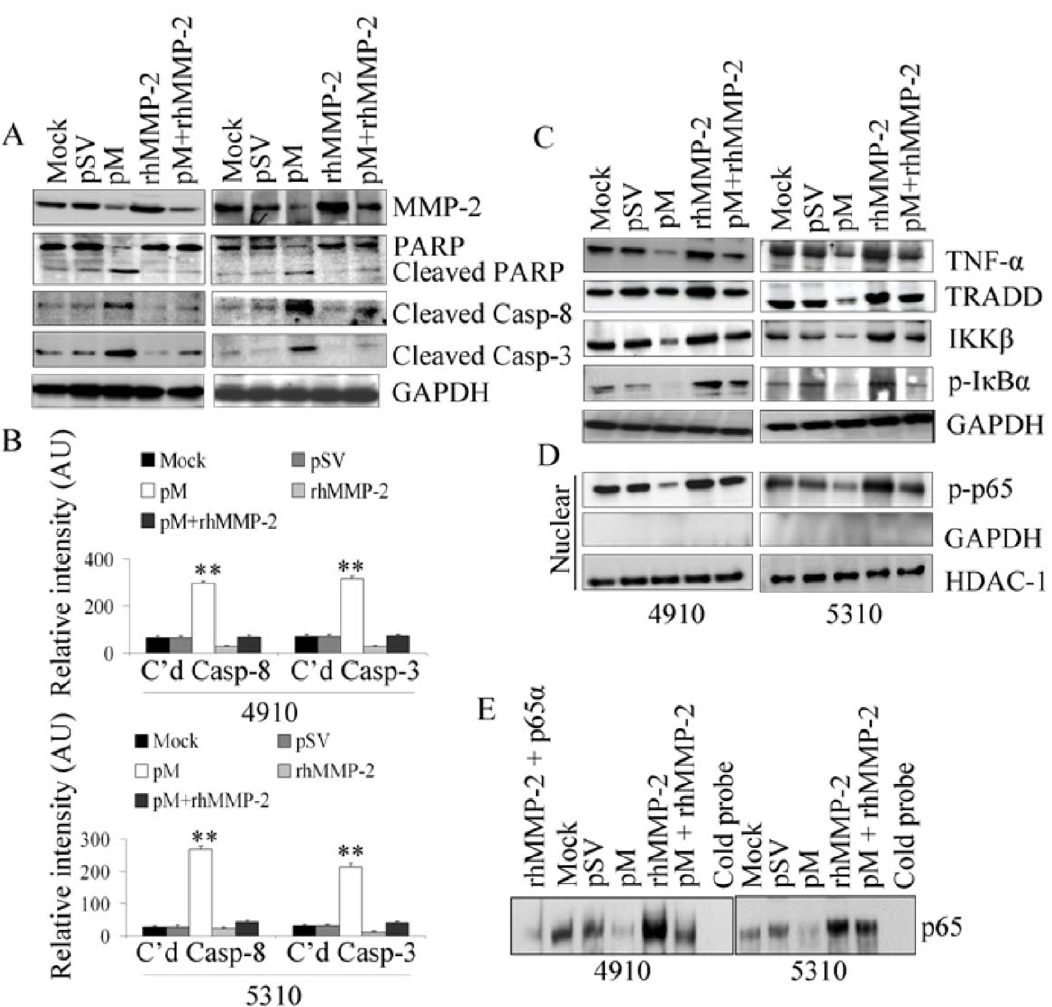
Figure 6. Effect of rhMMP-2 treatment on pM-inhibited NF- k B activity. A. The 4910 and 5310 cells were transfected with mock, pSV and pM for 48 h and treated with 25 ng/ml rhMMP-2 for another 24 h. Whole cell lysates from mock, pSV, pM, rhMMP-2, pM + rhMMP-2 treatments were prepared at the end of 72 h experiment and subjected to Western blotting to check the expression levels of MMP-2, and cleavage of PARP, caspase-8 and caspase-3. B. The relative intensity of cleaved caspase-8 and caspase-3 were quantified using ImageJ (NIH) software and plotted in the bar diagram using mean 6 SE and significant difference was represented by ‘‘**’’, at p , 0.01. C. The expression levels of TNF- a , TRADD, IKK b and, p-I k B a were checked for the possible reversal and upregulation of IKK b -pI k B a mediated NF- k B pathway. D. The nuclear fractions were checked for phospho- p65 expression levels in pM + rhMMP-2 combination treatment where HDAC-1 served as nuclear and loading control. E. Electrophoretic mobility shift assay showing the DNA binding activity of p65. Nuclear extracts at the end of 72 h were prepared from the mock, pSV, pM, rhMMP-2, pM + rhMMP-2 treatments as described above in 4910 and 5310 cells and subjected to EMSA where rhMMP-2 + p65 a antibody was loaded to check the shift and cold probe was loaded as negative